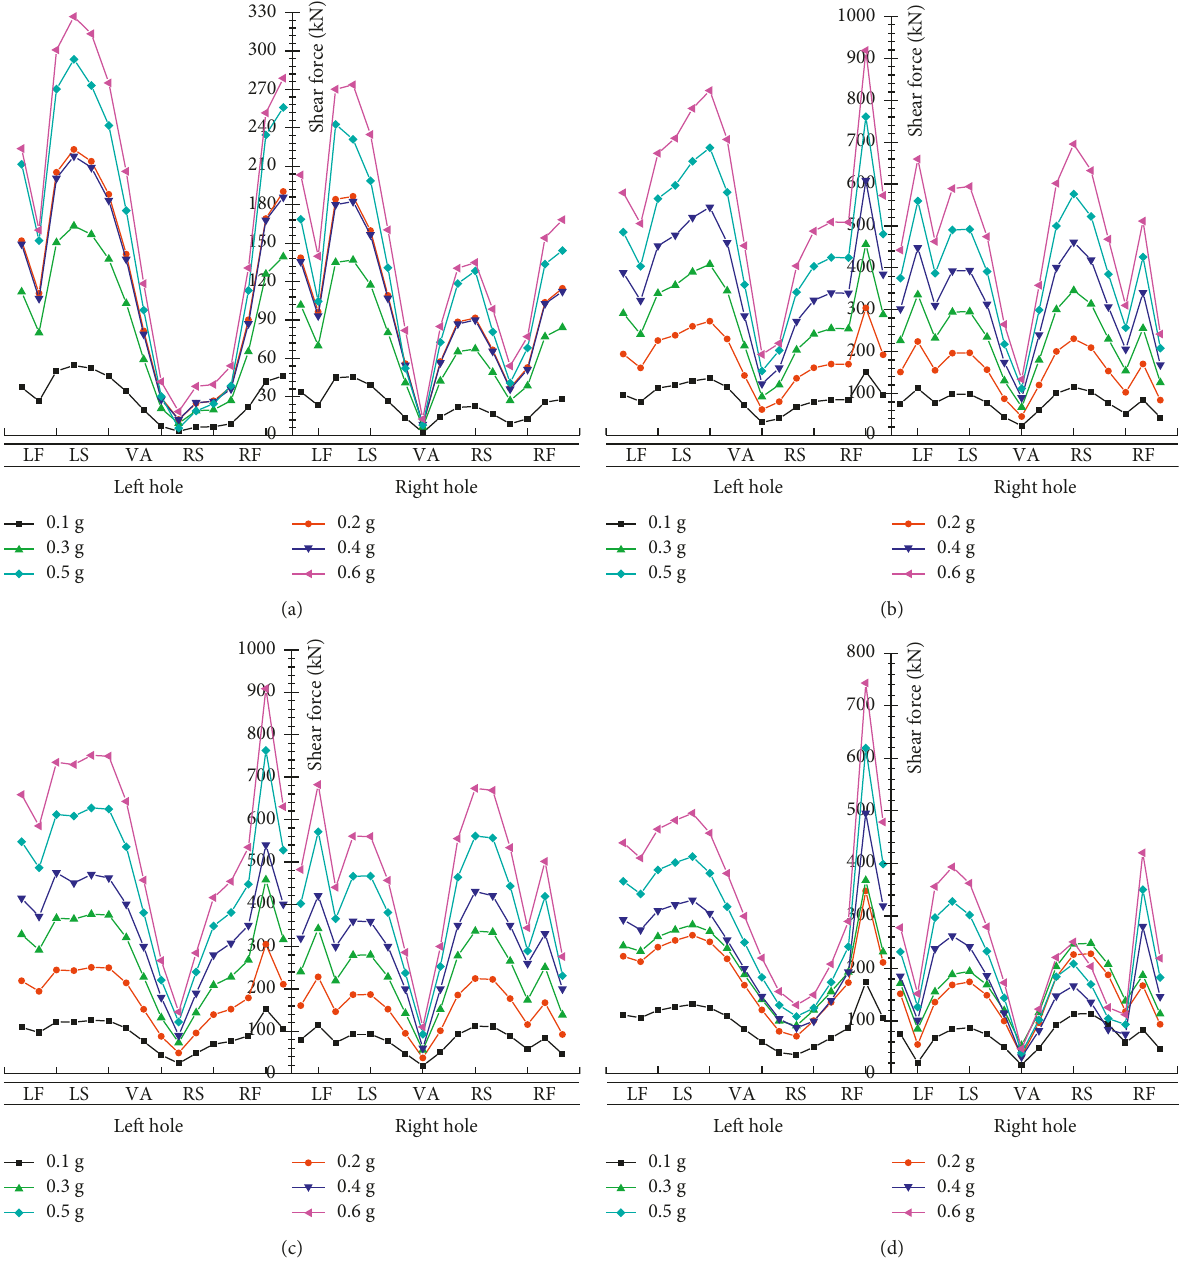
Figure 7: Shear force of the tunnel crosssection of different clear distances. (a) 1.0D, (b) 1.5D, (c) 2.0D, and (d)